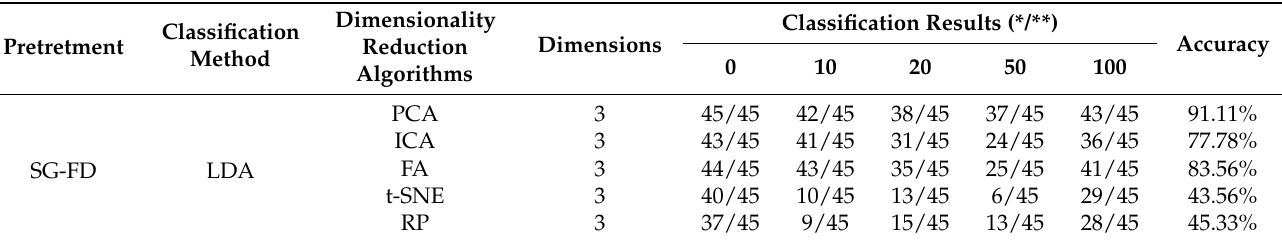
Table 3. Comparison the effect of different dimensionality reduction algorithms.